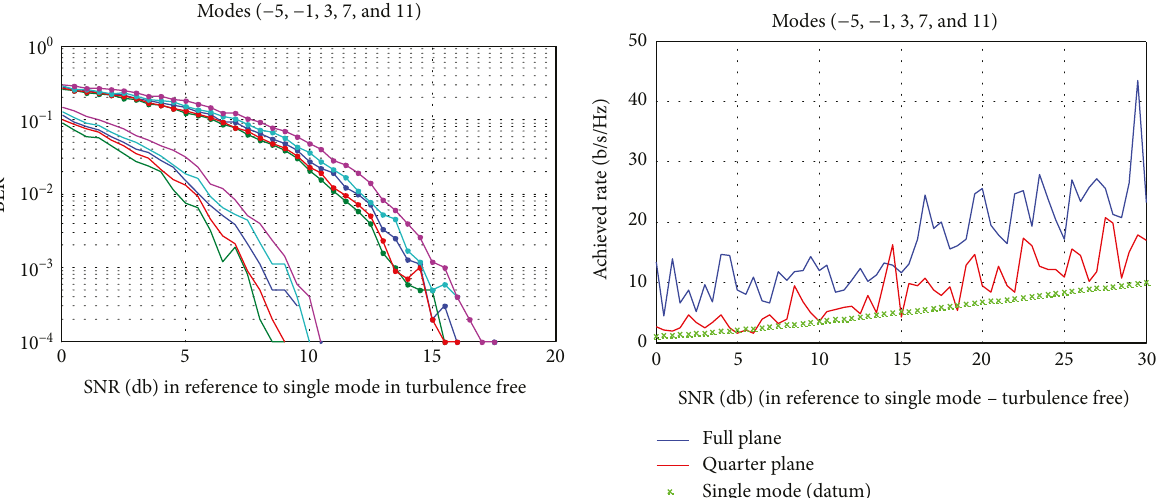
= 1 ; l = 0 01 ; w = 0 02 ; propagation 0 0 0